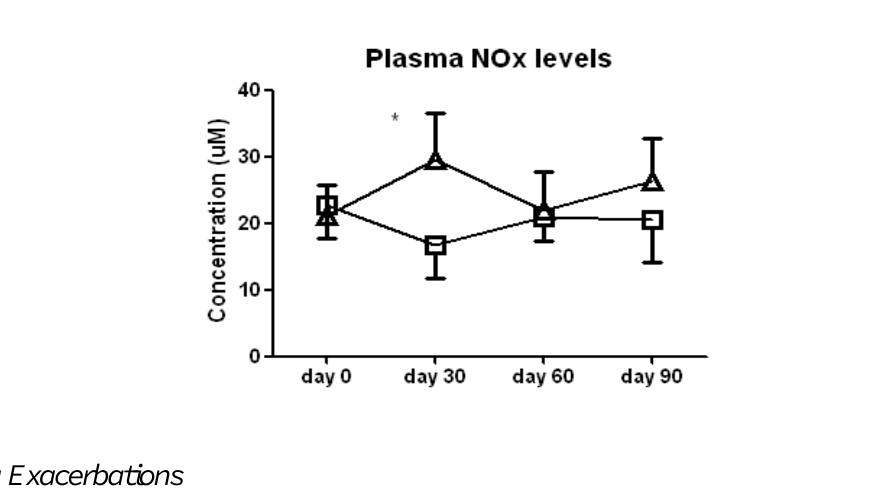
Figure 1. Serum nitrate and nitrite (NOx) concentration in subjects treated with L -arginine (triangles) or placebo (squares). Data are presented as mean ± SEM. * denotes p <